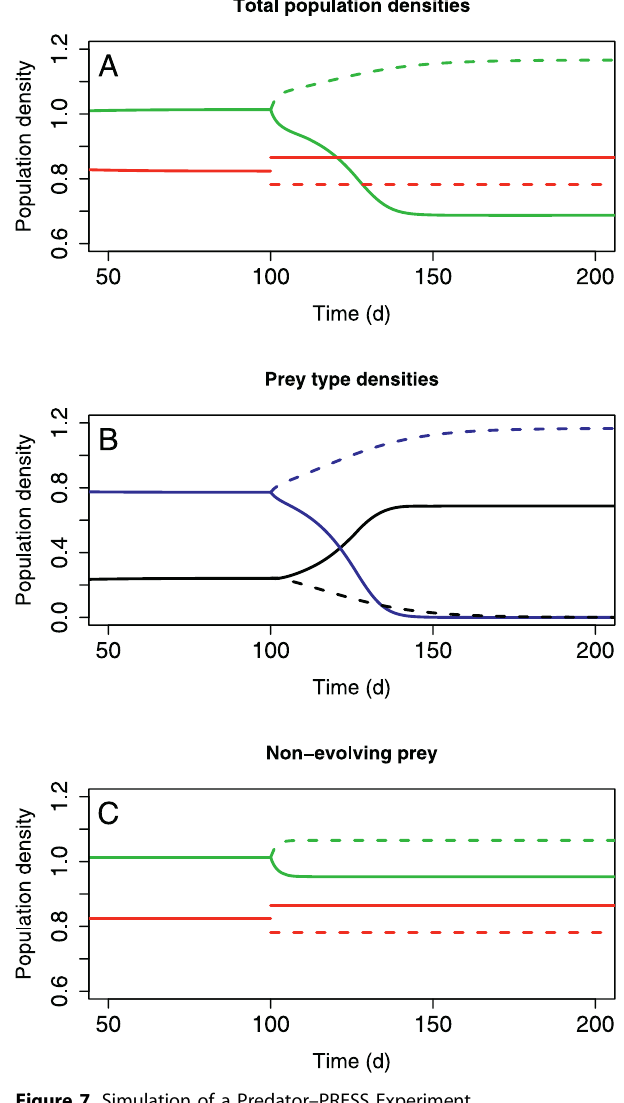
Figure 7. Simulation of a Predator–PRESS